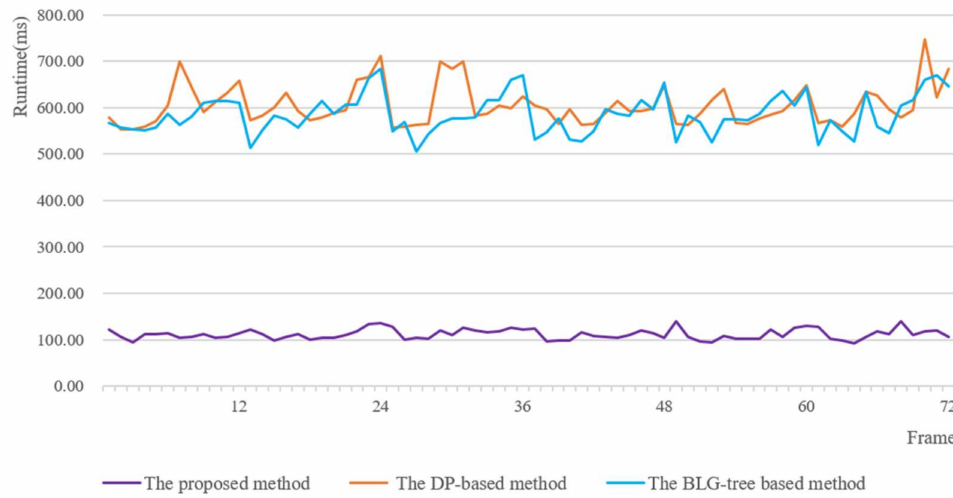
Figure 8. Rendering times for the test polygons using the three compared